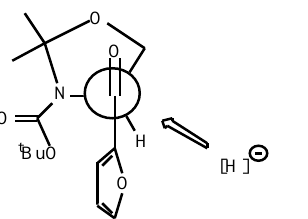
Figure 1. Proposed model for the reduction of 5